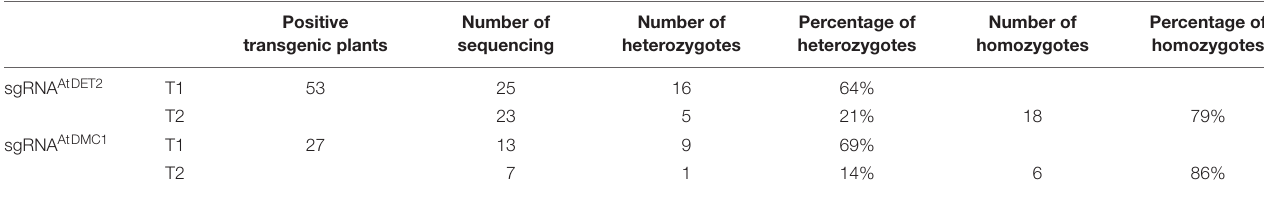
TABLE 1 | Mutation analysis of T1 and T2 plants.